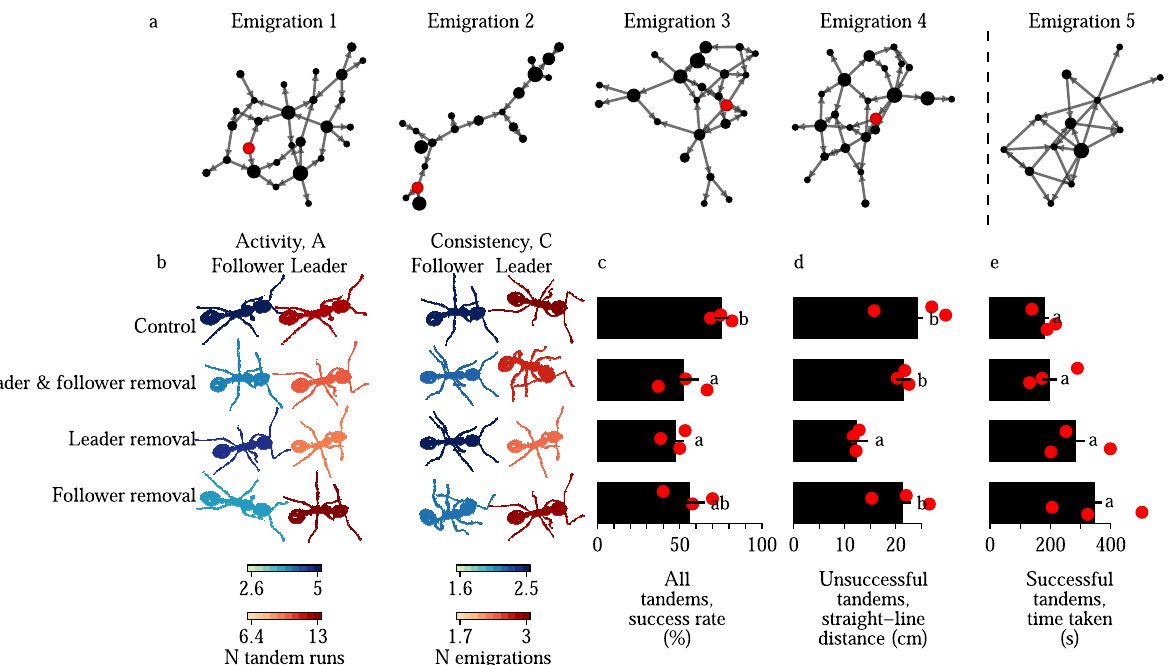
Fig. 3 Targeted worker removals show that tandem performance is most disrupted by removal of prominent leaders. a Tandem recruitment networks for one colony in the leader removal treatment. Links represent tandem runs, and are directed from the leader to the follower. Red node; a prominent leader with leading consistency C L = 4 emigrations, and leading experence A L = 12 tandem runs, which was removed between emigrations four and fi ve. Node size indicates the number of tandem runs each ant led across the four baseline emigrations. b The effect of the targeted removals upon the composition of tandem pairs. Colours indicate the mean activity or consistency for leaders and followers in a given treatment. c The proportion of tandem runs that successfully reach one of the high-quality nests without breaking up. d The distance that unsuccessful tandem runs cover towards one of the high-quality nests before breaking up. e The time taken for successful tandem runs to travel all the way to one of the new nests. Bars & errors represent the mean & standard errors, where the means are grand means calculated from the colony means (red points). Letters indicate post-hoc contrasts from the colony- level mixed-models.